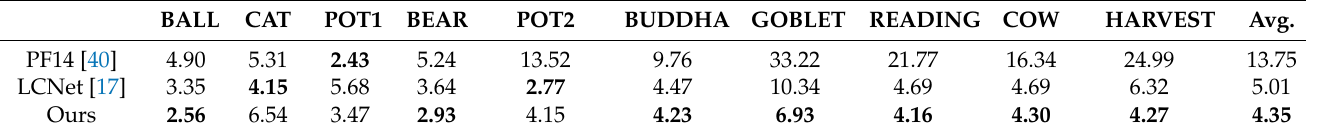
Figure 9. Quantitative light direction evaluation results on the Light Stage Data Gallery dataset. Left: Captured image and light direction error distribution on KNIGHT KNEELING for LCNet and ReDDLE-Net. Right: Captured image and light direction error distribution on KNIGHT STANDING for LCNet and ReDDLE-Net. We mapped the light source [ x , y , z ] to a point [ x , y ] . The color of points corresponds to the magnitude of the error. Table 1. The average light direction error on the DiLiGenT dataset. The numbers represent the MAE ( ◦